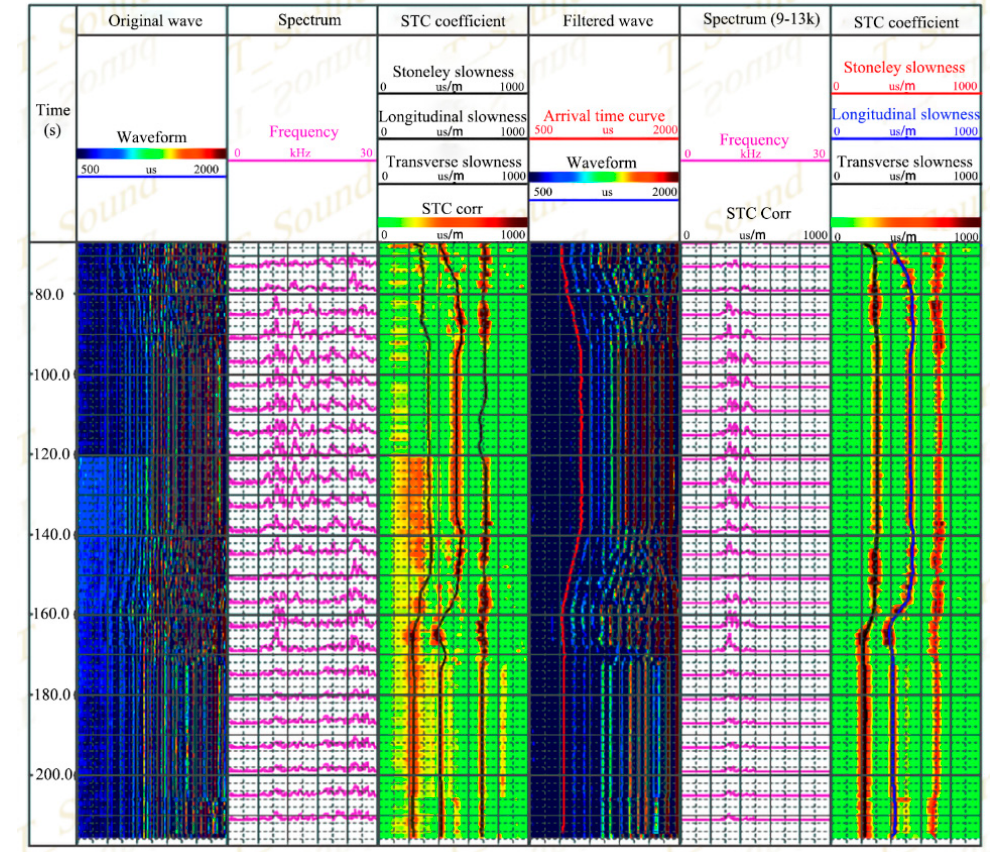
Figure 17. Continuous acquisition and STC results of anisotropic formation.